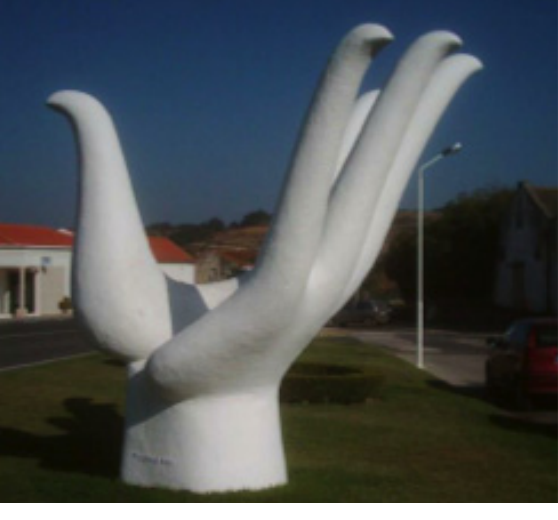
FIGURE 13 | J. Aurélio, Hand, 1966, Óbidos.